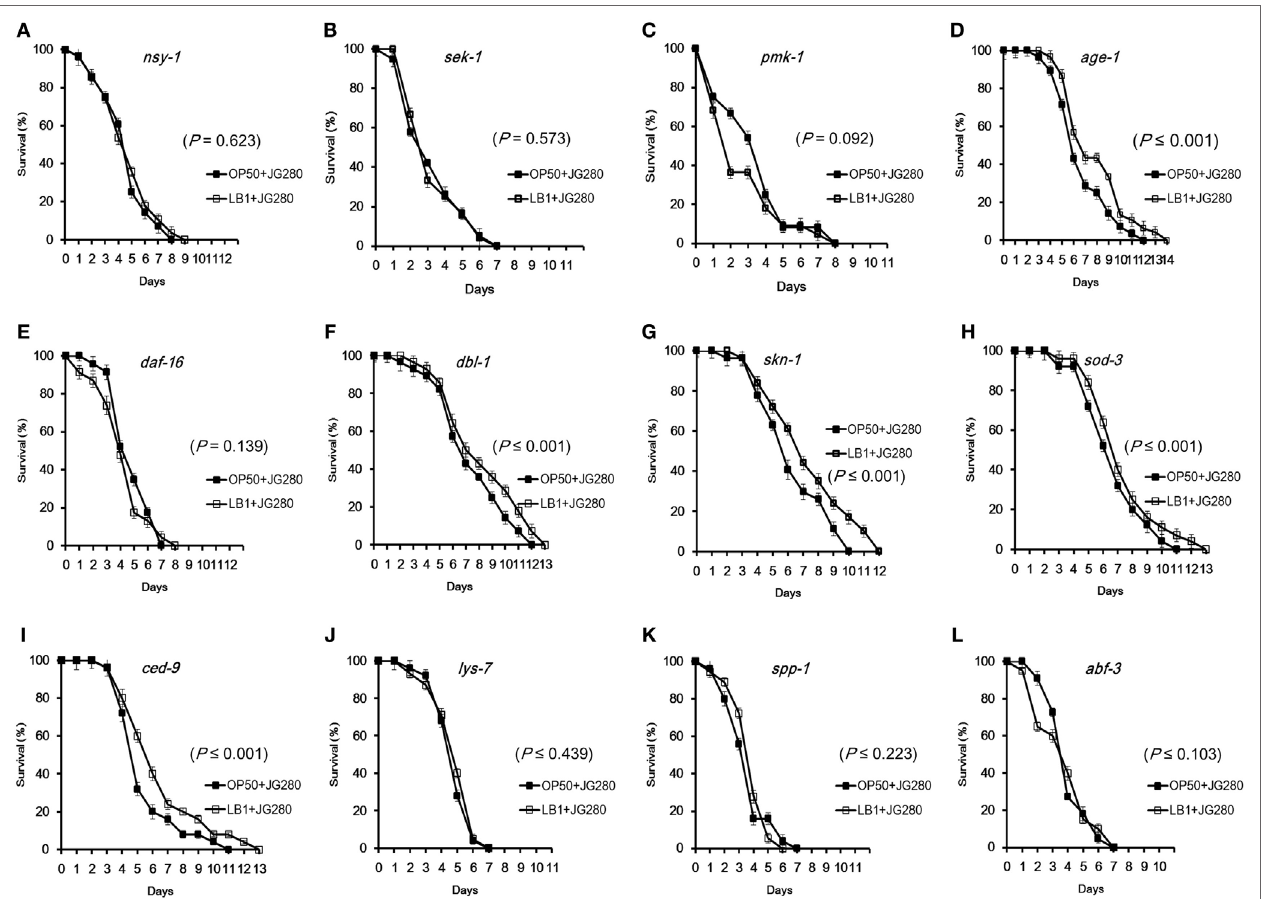
FigUre 4 | Effects of Lactobacillus zeae LB1 on the resistance to Enterotoxigenic Escherichia coli (ETEC) infection of Caenorhabditis elegans mutants defective in the genes for cell signaling or defense molecules and antimicrobial peptides. The mutants are defective in nsy-1 (a) , sek-1 (B) , pmk-1 (c) , age-1 (D) , daf-16 (e) , dbl-1 (F) , skn-1 (g) , sod-3 (h) , ced-9 (i) , lys-7 (J) , spp-1 (K) , or abf-3 (l) . The life-span assay was conducted in the absence or presence of L. zeae LB1 during the pretreatment. All C. elegans samples were treated with 10 8 CFU/ml isolate LB1 or E. coli OP50 (Control group) for 18 h and then ETEC JG280 for remaining days. Comparisons were made between the worms pre-exposed to L. zeae LB1 (LB1 + JG280) and those exposed to ETEC JG280 only (JG280). The P value for each comparison is indicated inside of each